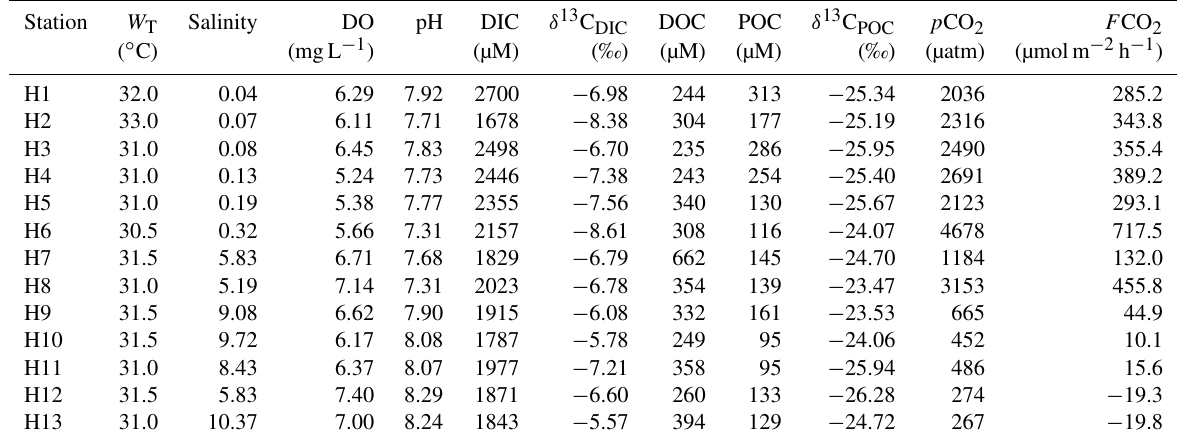
Table 3. Physicochemical parameters, inorganic and organic C-related parameters and CO 2 exchange flux across the water–atmosphere interface at the Hooghly estuary. Here, W T is water temperature, DO is dissolved oxygen.